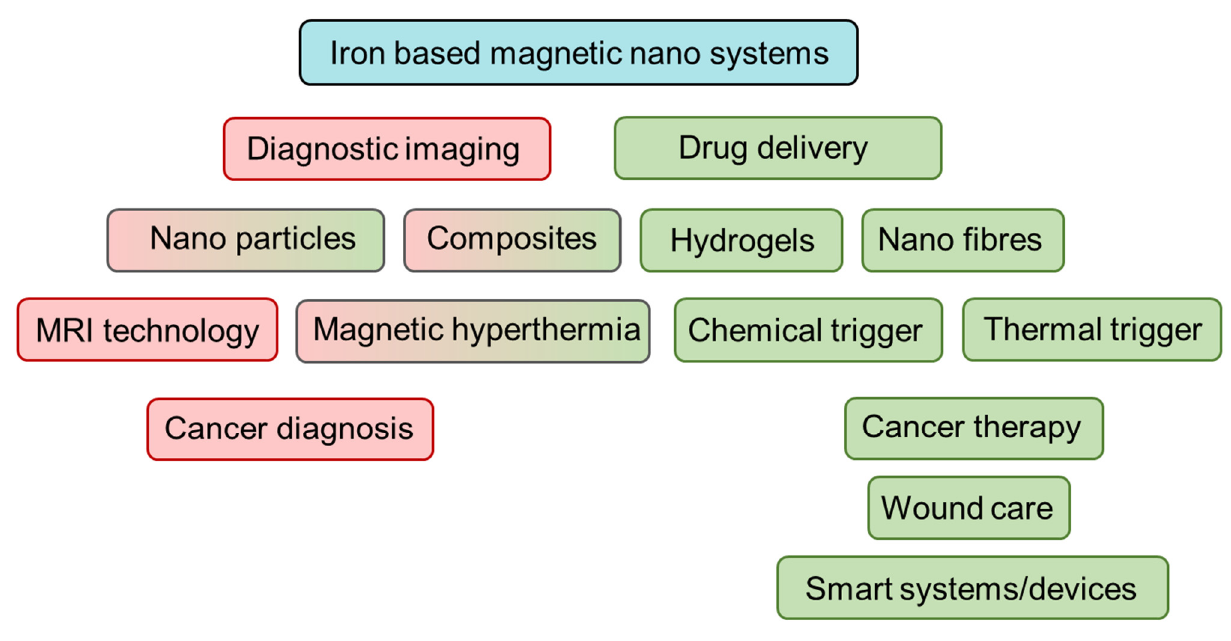
Figure 2. Overview of review topics discussed. Red depicts materials and methods and applications in diagnostic imaging and green represents the same in drug delivery. Boxes with combined red-green indicates both.